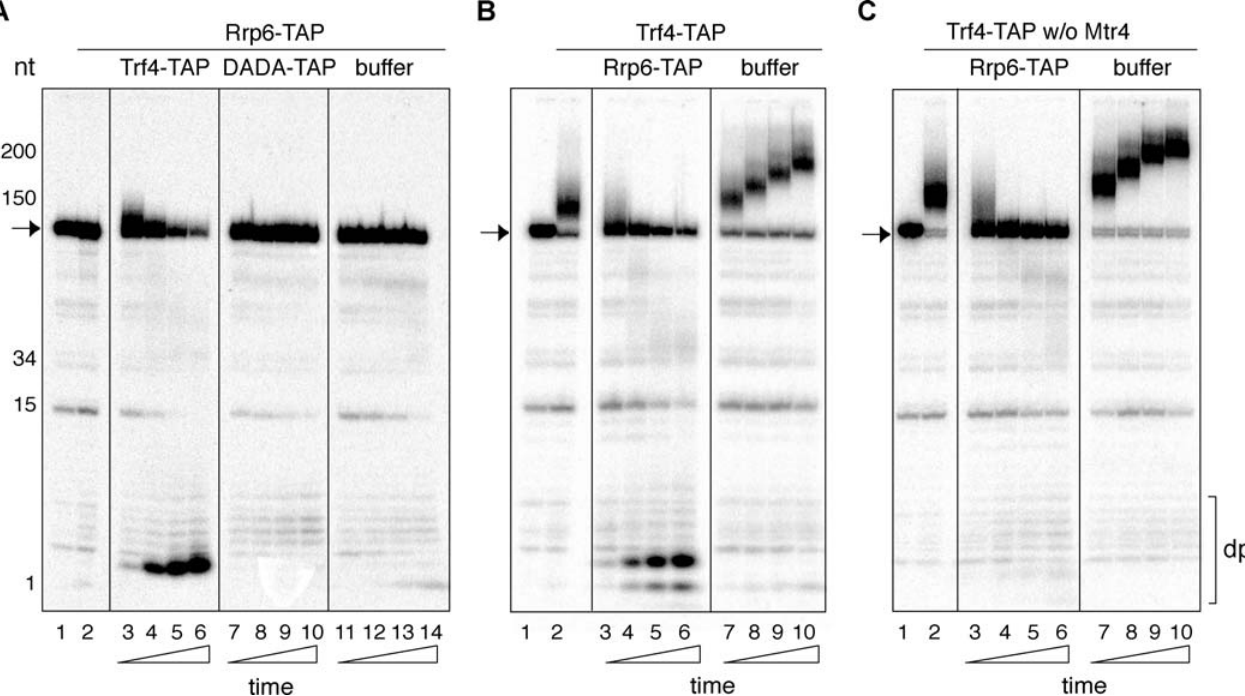
Figure 6. The Polyadenylation Activity of the Trf4 Complex Stimulates the Degradation of Unmodified tRNA iMet by the Nuclear Exosome (A) The PAP activity of Trf4 complex is required to stimulate the exosome activity. In a coupled exosome/polyadenylation assay, 5 9 -end-labeled unmodified tRNA iMet was incubated with 50 ng of affinity-purified Rrp6-TAP eluate for 30 min as described in Materials and Methods (lane 2), followed by addition of 50 ng of wild-type (Trf4-TAP), mutant complex (DADA-TAP), or buffer A (buffer). Reactions were stopped after 10 (lanes 3, 7, and 11), 30 (lanes 4, 8, and 12), 60 (lanes 5, 9, and 13), or 90 min (lanes 6, 10, and 14) and separated on a 15% gel. Arrows indicate the position of the input tRNA. Protein was omitted in lane 1 of each gel. The migration positions of the degradation products (dp) are indicated by a bracket. (B) Coupled polyadenylation/exosome assay. The 5 9 -end-labeled unmodified tRNA iMet was pre-adenylated with 50 ng of affinity-purified Trf4- TAP complex for 30 min (lane 2). Then 50 ng of exosome complex (Rrp6-TAP) or buffer A (buffer) was added, and the reactions were continued as in (A). (C) Depletion of Mtr4p results in incomplete degradation. Coupled-assay, 5 9 -end-labeled unmodified tRNA iMet was pre-incubated for 30 min with Trf4p-TAP lacking Mtr4p (Trf4-TAP w/o Mtr4), followed by the addition of 50 ng of Rrp6-TAP complex or buffer A, and the incubation